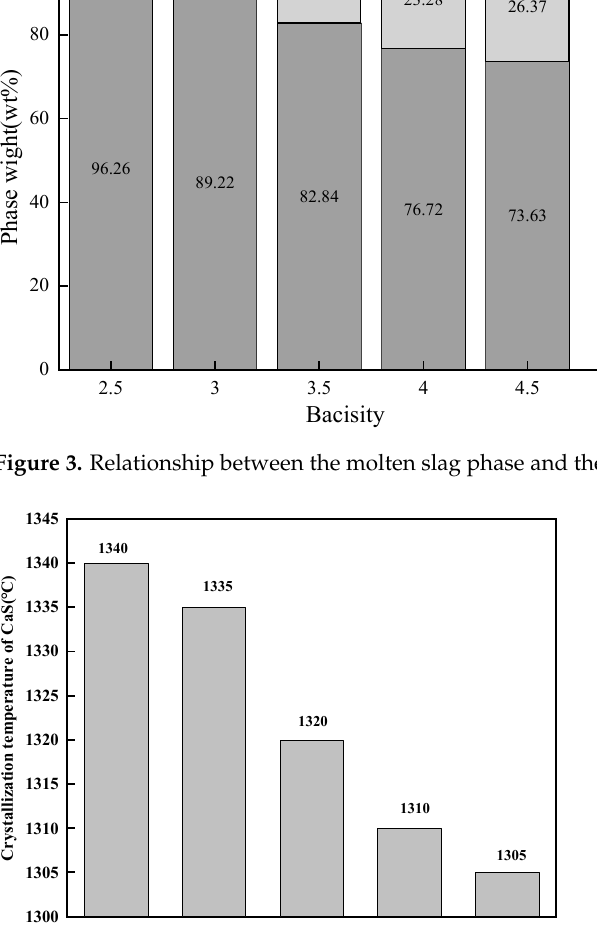
Figure 3. Relationship between the molten slag phase and the basicity at 1600 °C .